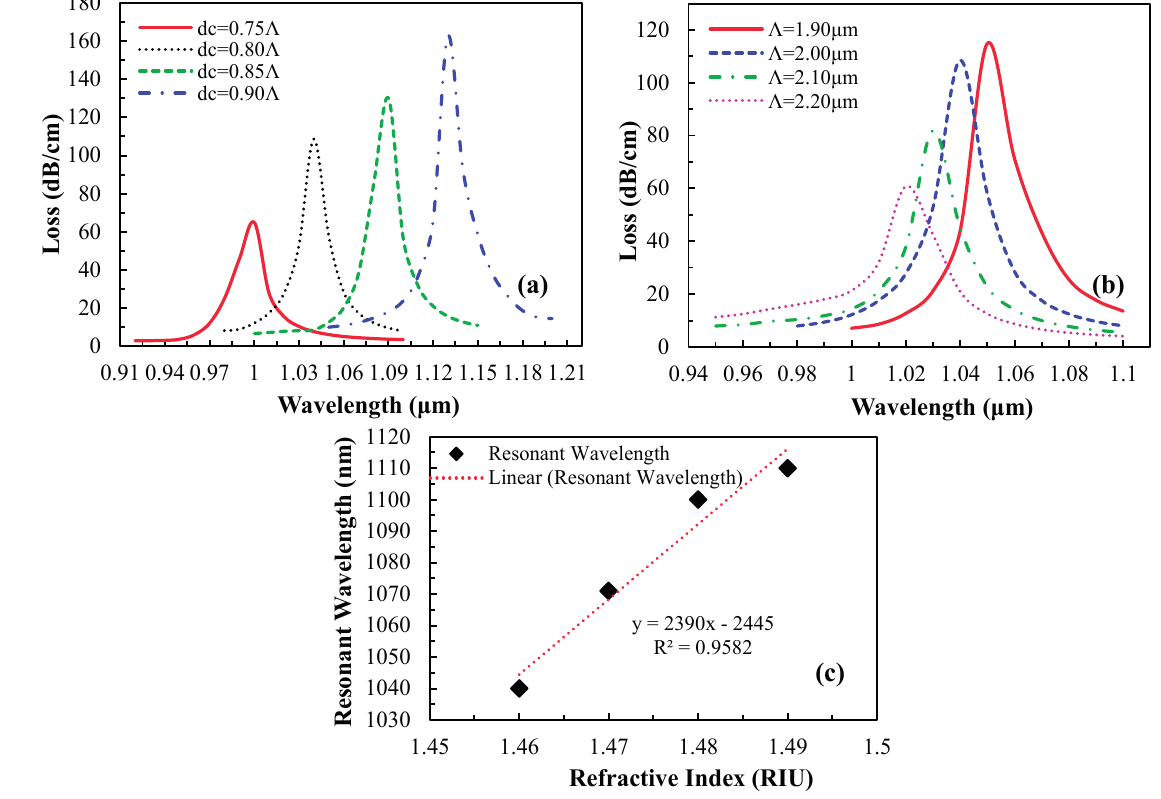
Figure 7. Loss spectrum vs. wavelength with the variation of ( a ) metallic core diameter d c , ( b ) pitch size Λ (analyte RI, n a = 1.46) and ( c ) linear fitting of the fundamental mode resonant wavelength vs. analyte